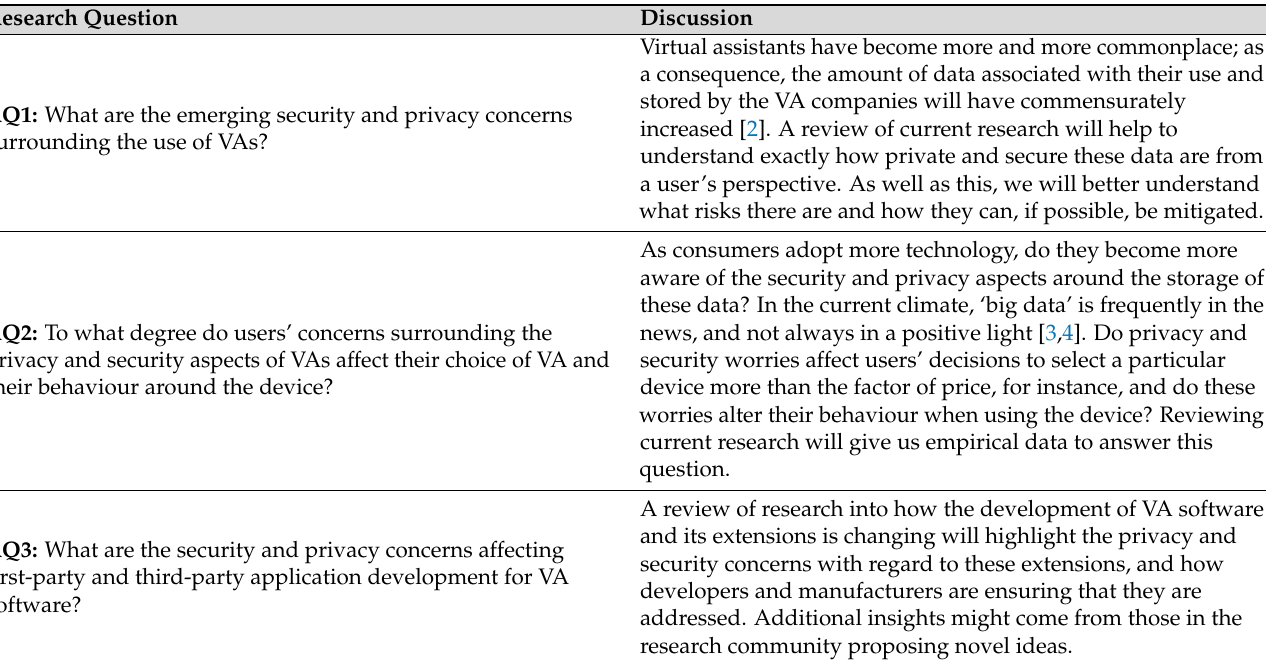
Table 1. Research